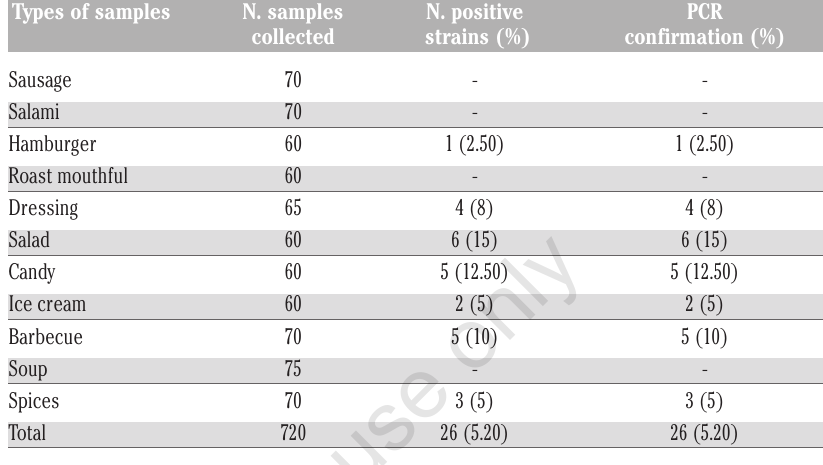
Table 2. Prevalence of Escherichia coli strains in various types of ready to eat food sam- ples. Types of samples